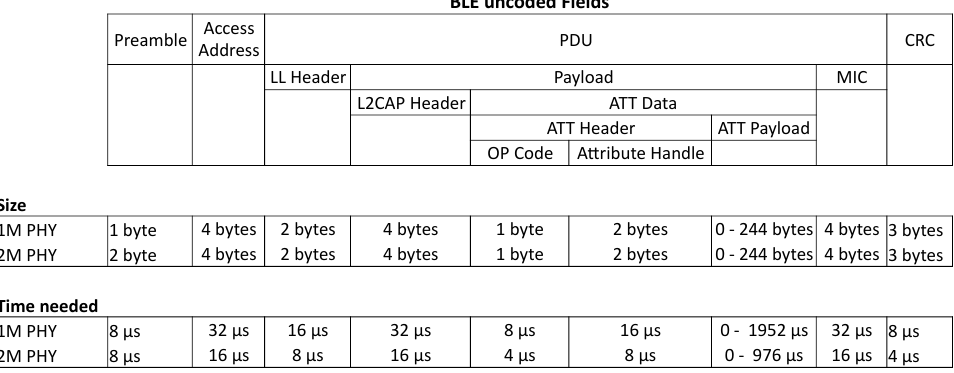
Figure 2. Uncoded packet structure.